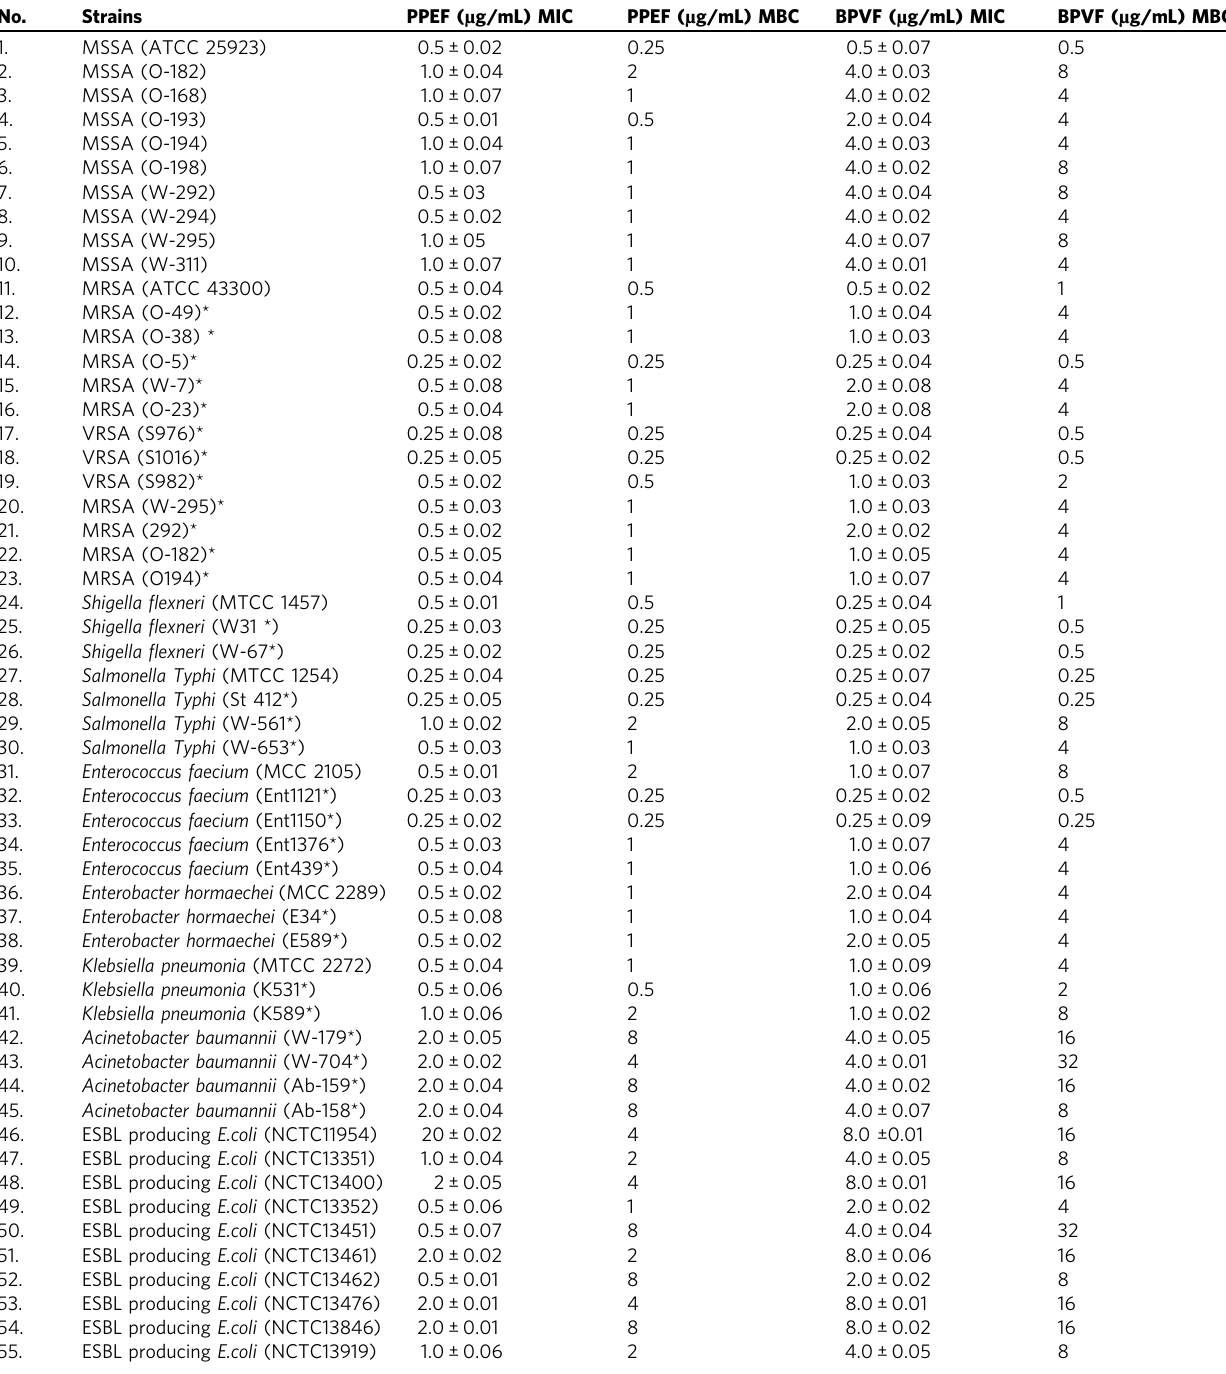
Table 1 Broad spectrum activity of PPEF, BPVF, and standard antibiotics against WHO-priority pathogens bacterial strains.